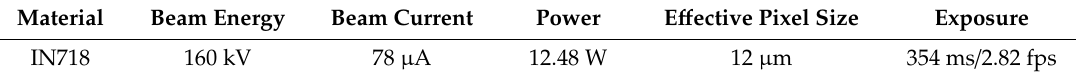
Table 1. Scanning parameters for computed tomography ( µ -CT)